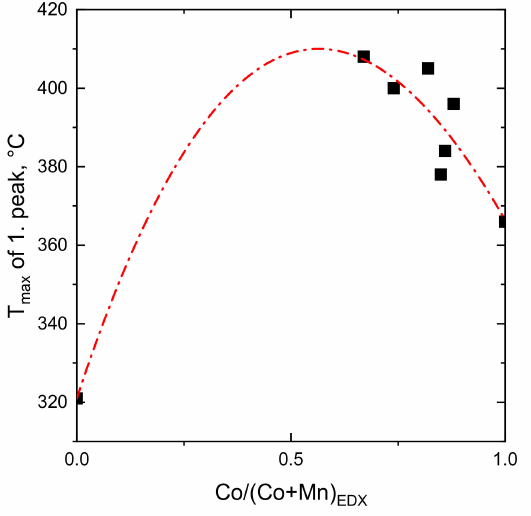
Figure 9. Relation between the Co/(Co + Mn) molar ratio determined by EDX and the position of the first reduction peak in the H 2 -TPR